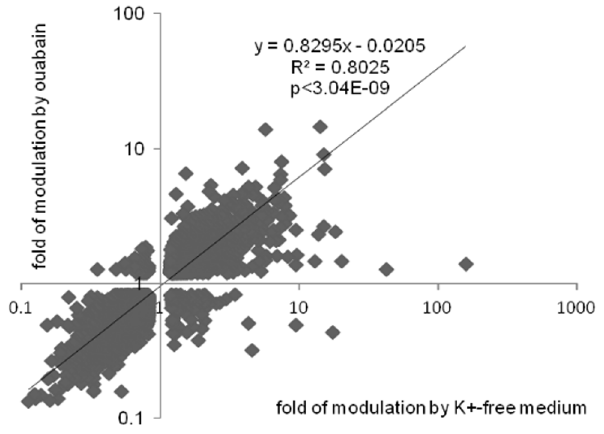
Figure 4. Correlation analysis of transcripts whose expression is altered by ouabain and K + -free medium in RVSMC by more than by 1.2-fold with p , 0.05. The total number of transcripts subjected to analysis is shown in Figure 2B. Transcript expression in control cells was taken as 1.00. The fold change was determined as log transformed treatment/control expression ratio.